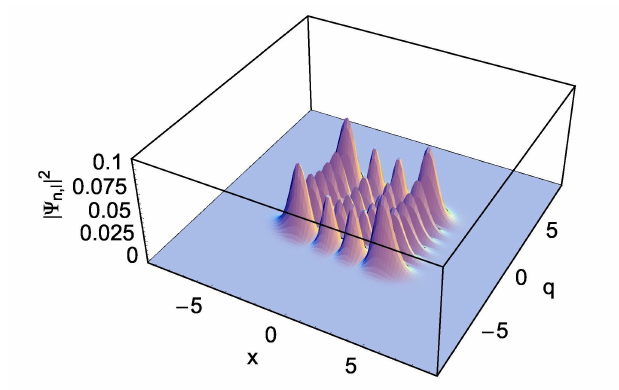
Figure 3. This figure is the same as Figure 2C, but for a different choice of angular frequencies. The values of ( ω , Ω ) are (0.49,